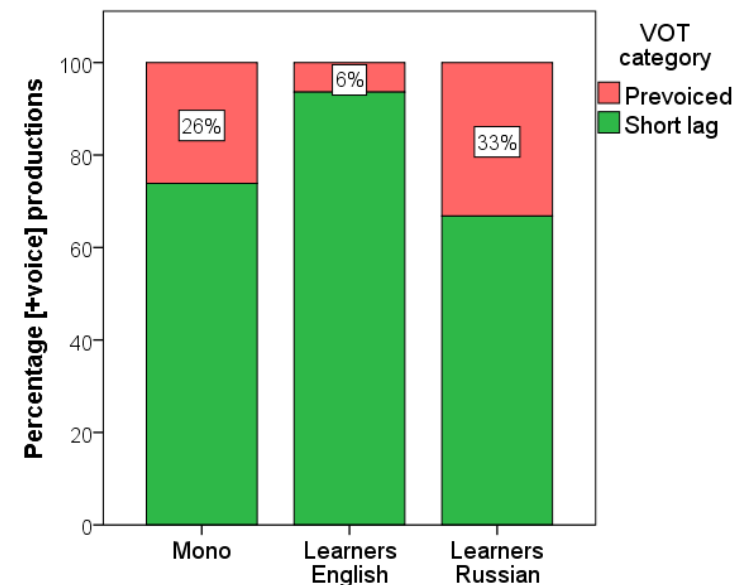
Figure 8. Percentage of prevoiced productions among [+voice] stops in monolingual controls’ and learners’ English; learners’ Russian is provided for comparison.